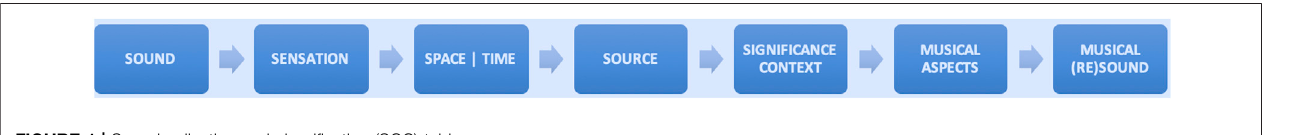
FIGURE 1 | Sound collection and classi fi cation (SCC)